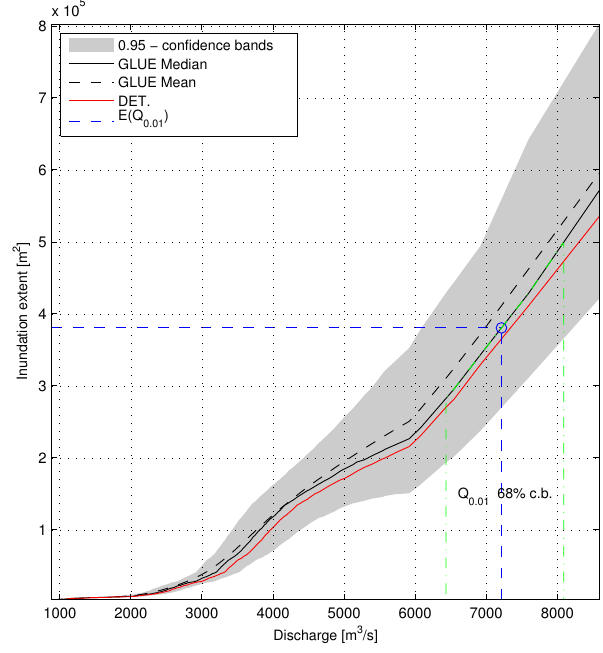
Fig. 9. Relationship between the inundation extent and the input flow rate for the ZOO area. Continuous red line denotes the deter- ministic solution, black continuous line denotes the median, black dashed line denotes the mean and gray shaded area denotes 0.95 confidence bands; blue dashed lines show a 1-in-100yr flow and corresponding inundation extent value; green dashed lines denote 0.68 confidence limits.